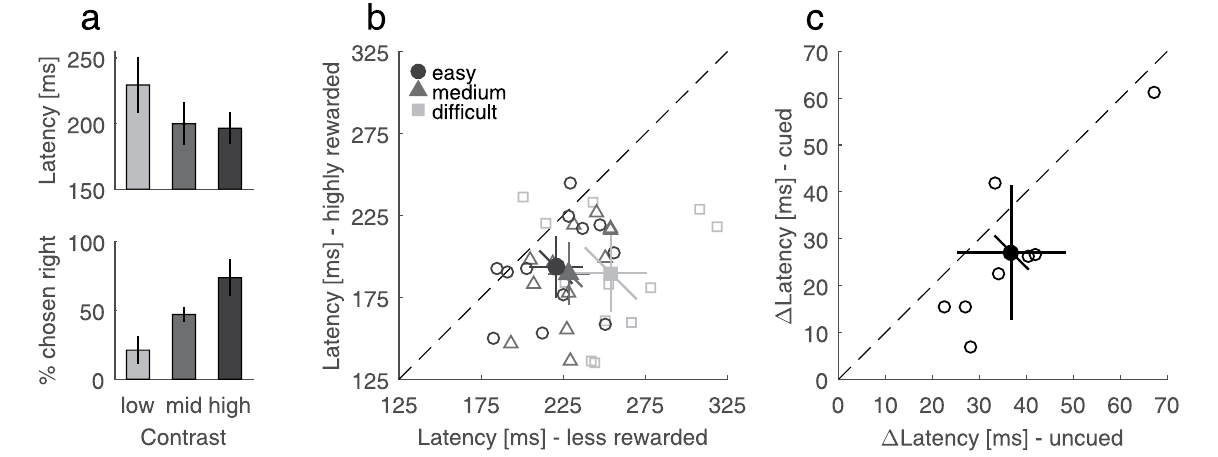
Figure 4. Adaptive inhibition of the non-chosen target. ( a ) Control latency task (top panel) and control choice task (lower panel) of Experiment 4, both without reward. With increasing target contrast, latency in single- trials decreased and the target with the higher contrast was preferably chosen in choice-trials. ( b ) Latency to the highly versus the less rewarded target for the different levels of difficulty (Experiment 4). The difference in single-trial latency increased with increasing difficulty in choice-trials. ( c) Results of cueing (Experiment 5). Latency differences between less and highly rewarded single-trials were reduced when single-trials were cued compared to